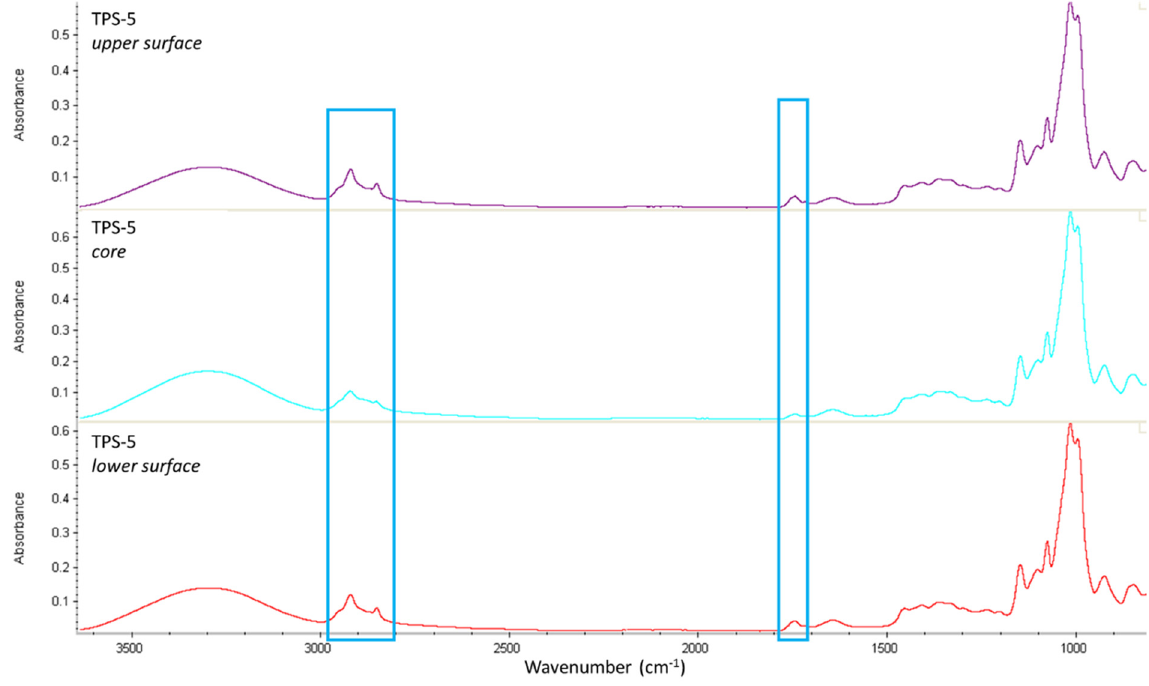
Figure 4 . FTIR spectra for TPS-5 (upper surface, core and lower surface).